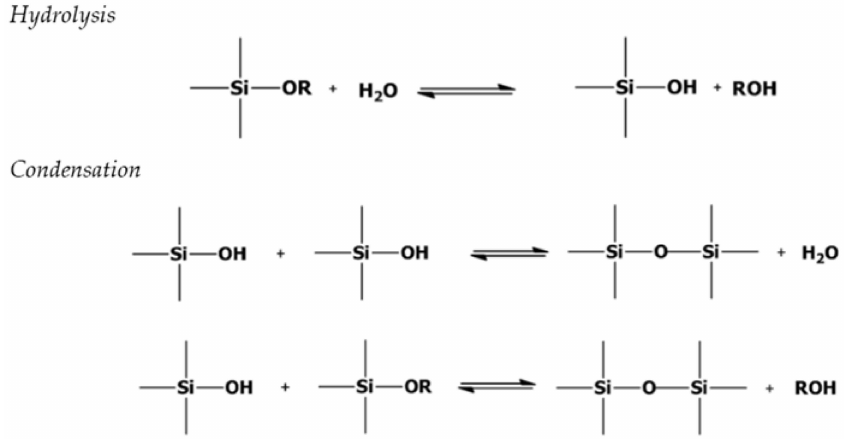
Scheme 2. Chemical processes in a sol-gel procedure on silicon